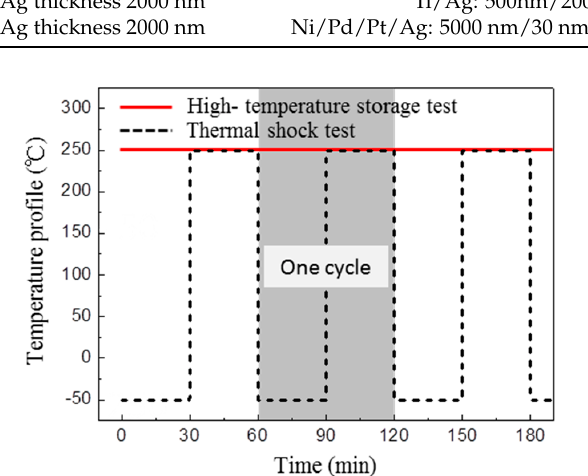
Figure 2. Profiles of harsh environmental tests: high temperature storage test at 250 °C and thermal cycling test at − 50/250 °C.